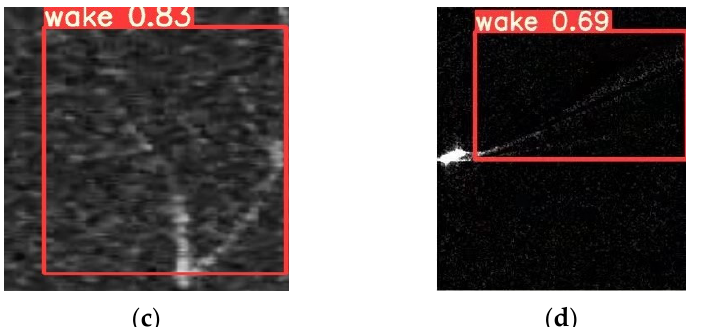
Figure 16. Results of ship wake recognition: ( a ) single target; ( b ) multiple targets; ( c ) nonlinear wake; ( d ) weak wake.